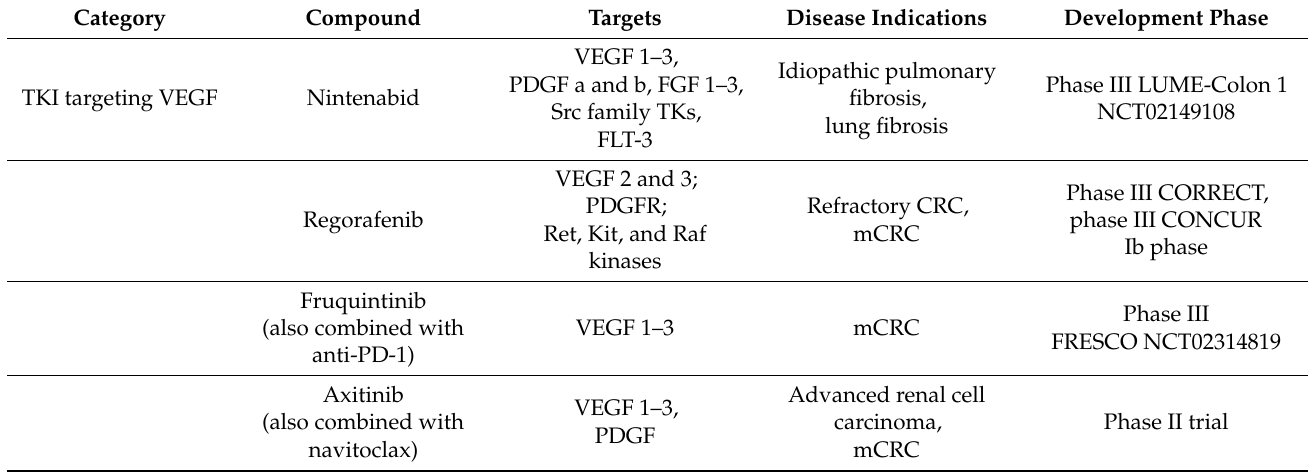
Table 1. Emerging therapeutic agents for colorectal cancer covered by this